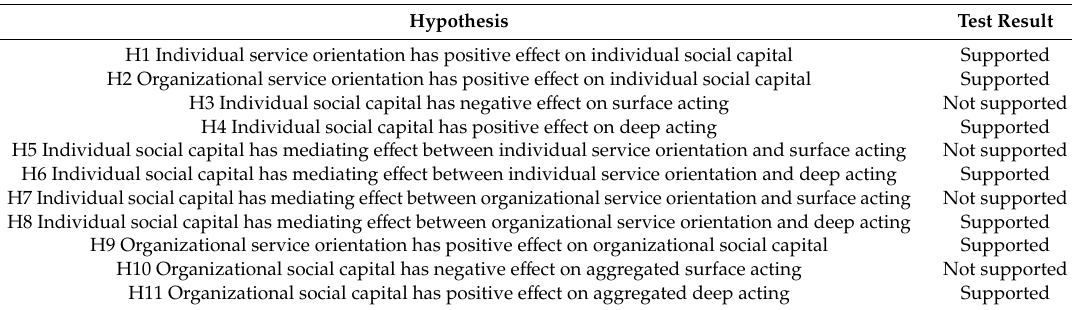
Table 12. Research hypothesis test